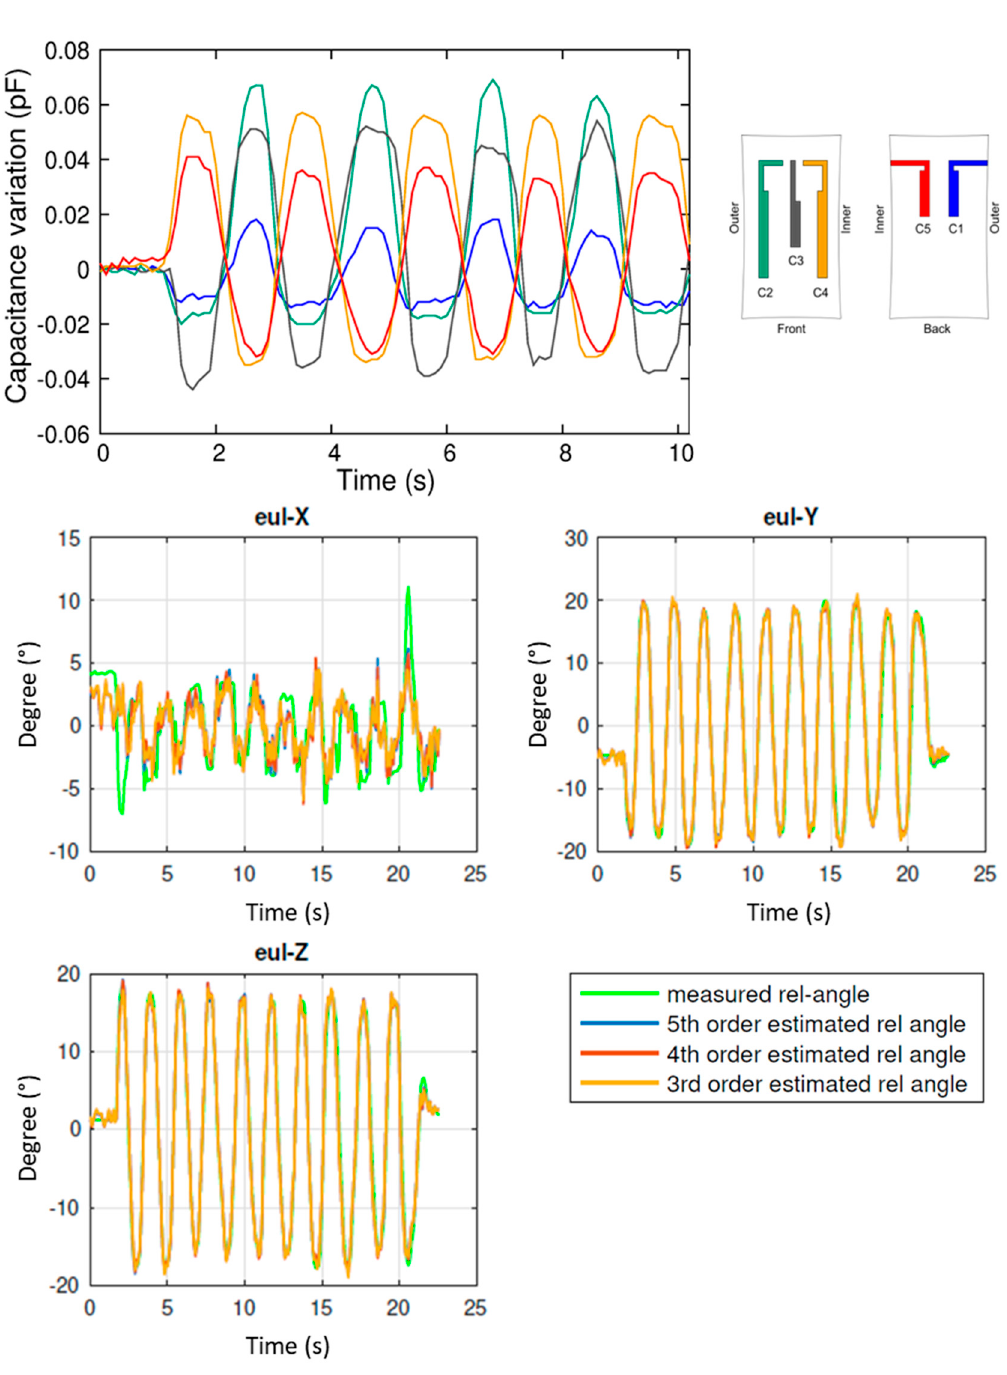
Figure 10. Results of the experimental analysis during plantar abduction/adduction during. Top panel : raw capacitance variations of sensors C1 to C5. Bottom panels : reconstruction of the Euler angles (Eul-X, Eul-Y, Eul-Z), and comparison with the values (in green) measured by the optical tracking system.